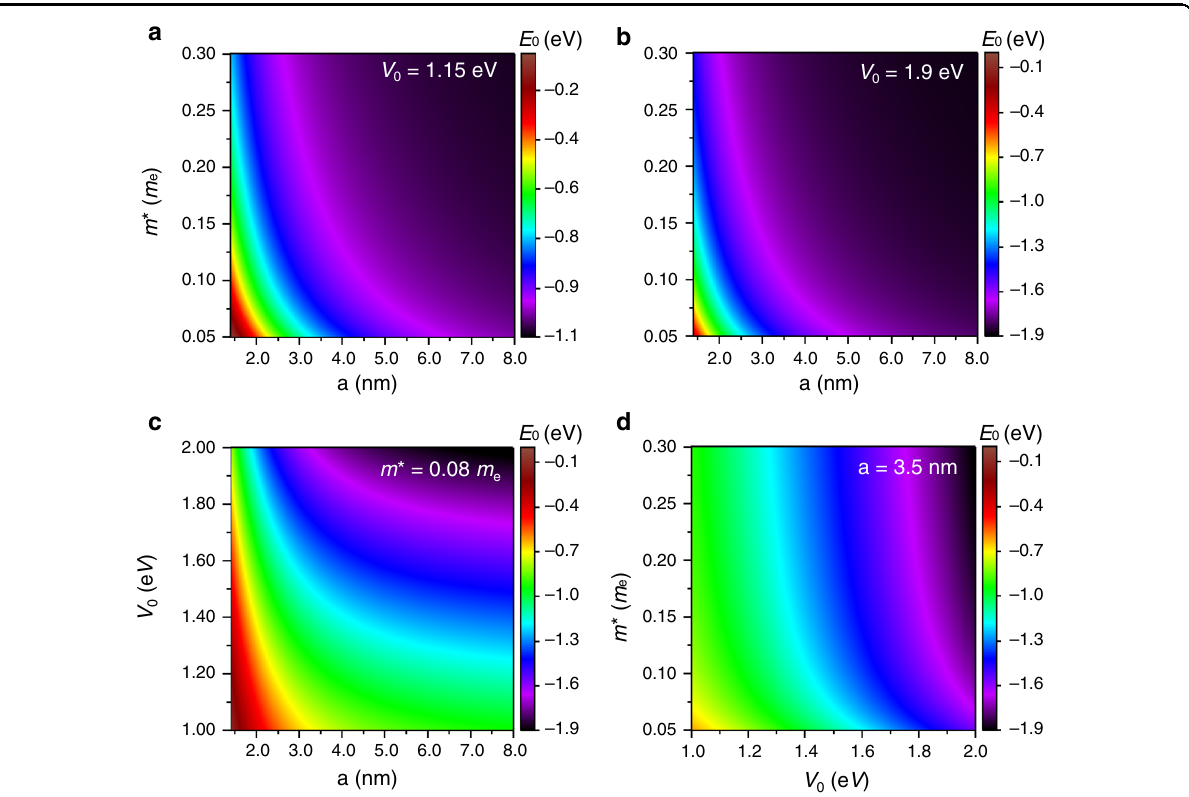
Fig. 3 Inter-parameter relations for several combinations of QD properties, calculated for the ground-state energy level, E 0 . a Relation between the QD effective mass ( m *) and radius ( a ) for a potential barrier ( V 0 ) of 1.15 eV. b Relation between the QD effective mass and the radius for V 0 of 1.90 eV. c Relation between the potential barrier and the QD radius. d Relation between the QD effective mass and potential barrier, where a 3.5 nm QD radius is considered to guarantee at least one con fi ned energy level in the full range of the pro fi